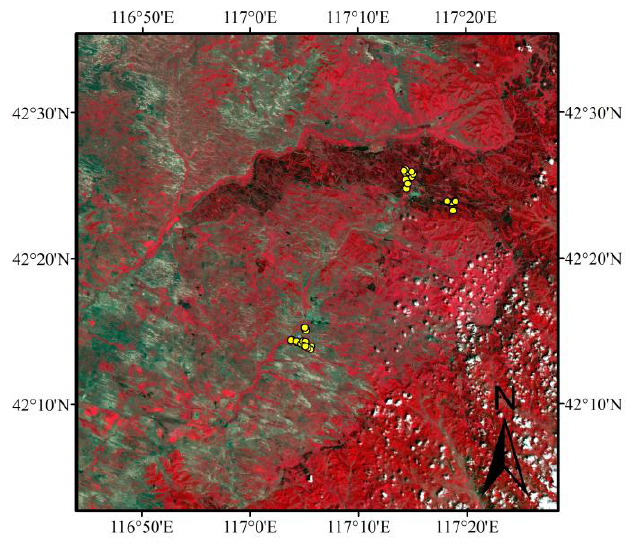
Figure 4. The geographic location of the Chengde test area and locations of the ground measurements are displayed as yellow dots.